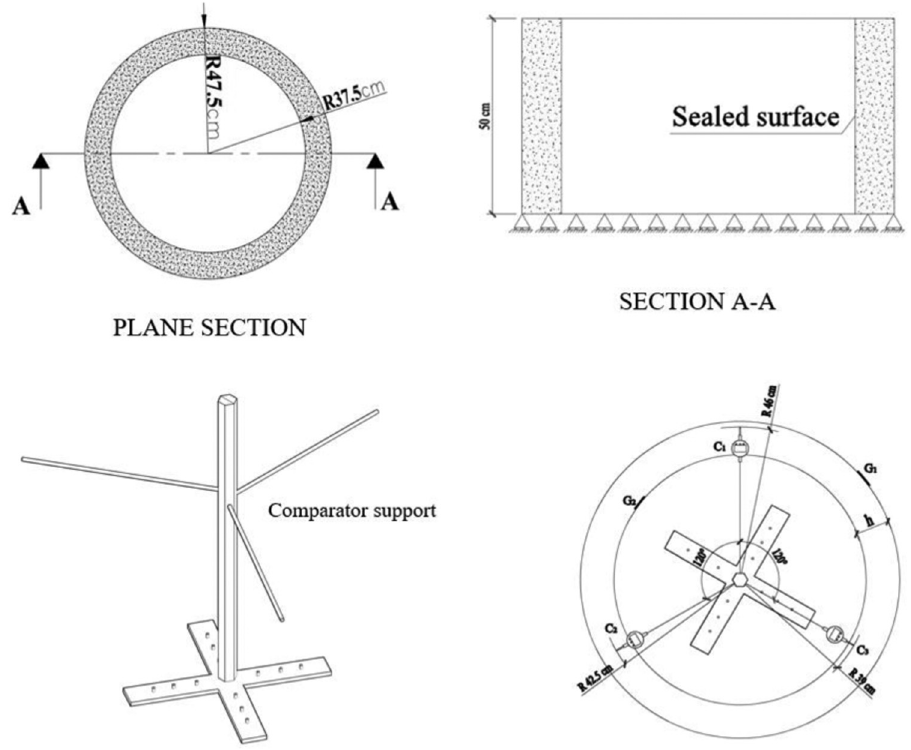
Figure 3: Geometry details of the test